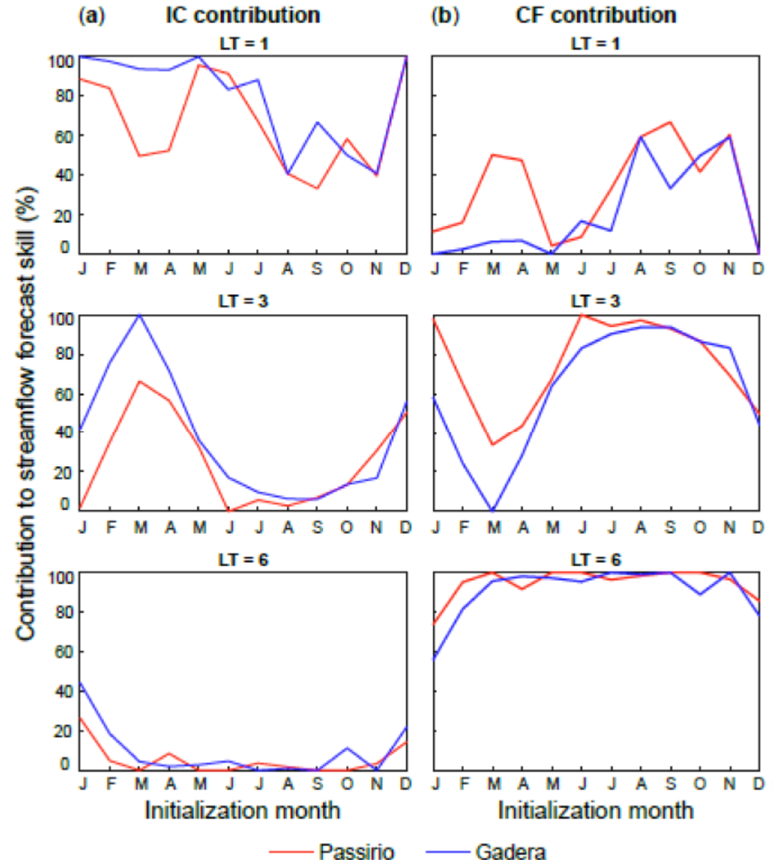
Figure 10. Contribution of ( a ) IC; and ( b ) CF to the streamflow forecast skill (expressed in percentage of the total forecast skill) over the two case studies, for each initialization month and LT of 1, 3 and 6 months.